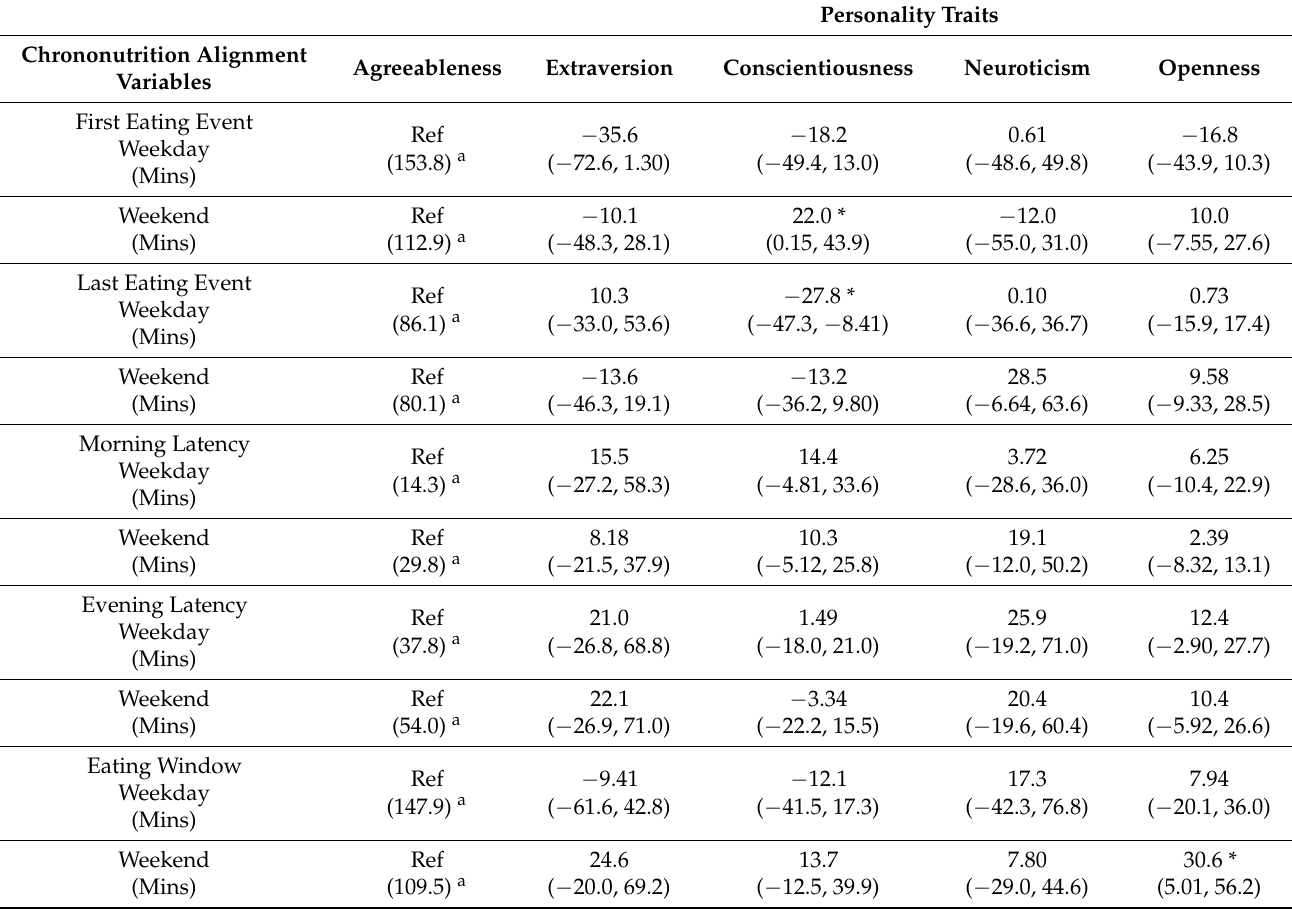
Table 5. Mean differences (95% confidence intervals) for the association between chrononutrition alignment and personality during the COVID-19